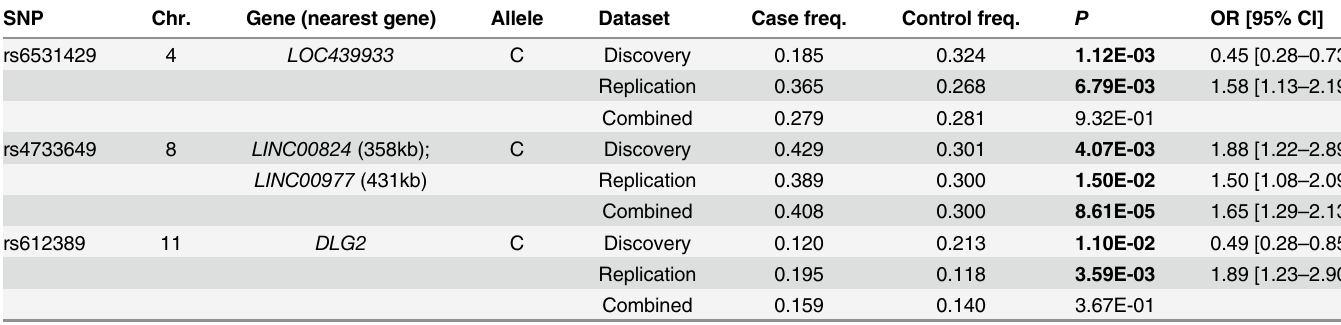
Abbreviations: Chr., chromosome; freq., frequency; P , logistic regression P -value using the log-additive model. The SNPs are ordered by chromosomal position. Nominally signi fi cant associations are highlighted in bold and their respective OR (odds ratio) and 95% CI (con fi dence interval) are